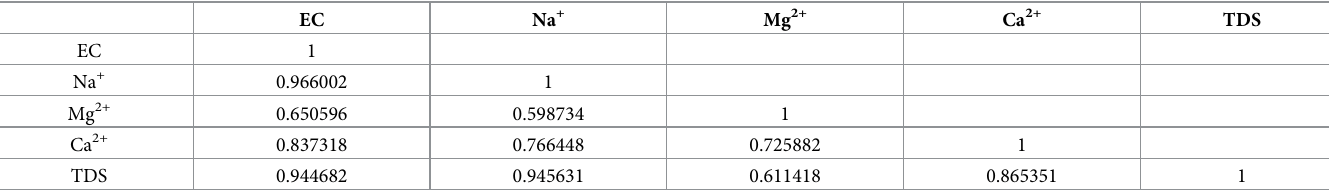
concentration from the 0.75 m column depth was 134.36 μ S/cm, while that of 1 m column